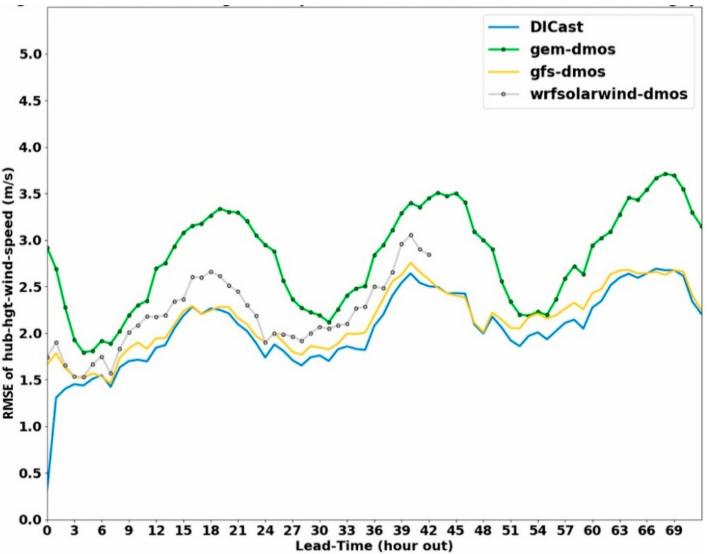
Figure 5. Average root mean square error (RMSE) of hub-height wind speed over the period 1 December 2018 to 30 November 2019 for forecasts valid at 06